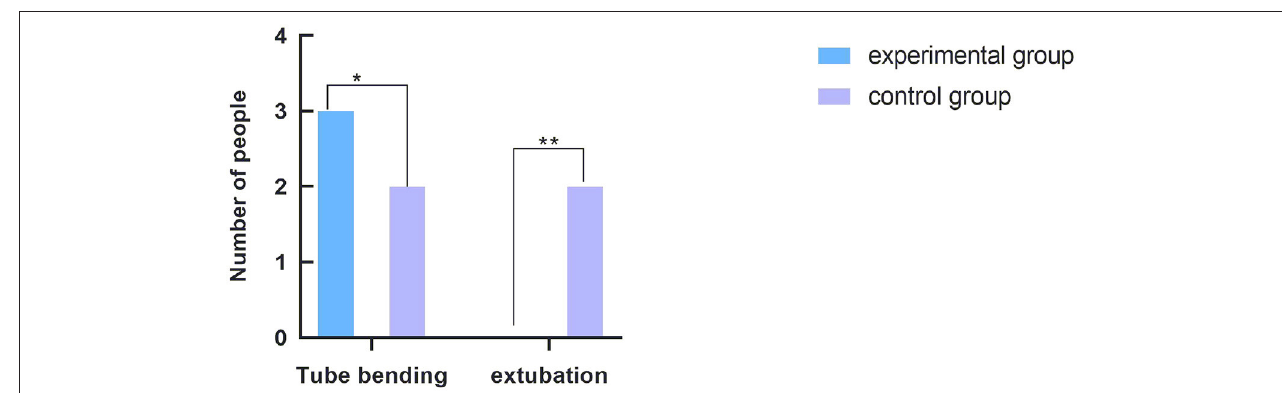
FIGURE 3 | Comparison of influencing factors of nursing efficiency. The abscissa indicates the factors affecting the nursing efficiency. From left to right, the coordinates are tube bending and extubation. The ordinate indicates the number of people. *The comparison of catheter bending in the nursing process between the two groups, with three cases in the experimental group and two cases in the control group. The difference was not statistically significant ( P = 0.64). **The comparison of extubation and reinsertion in the nursing process between the two groups. There were no cases in the experimental group and two cases in the control group, and the difference was not statistically significant ( P =